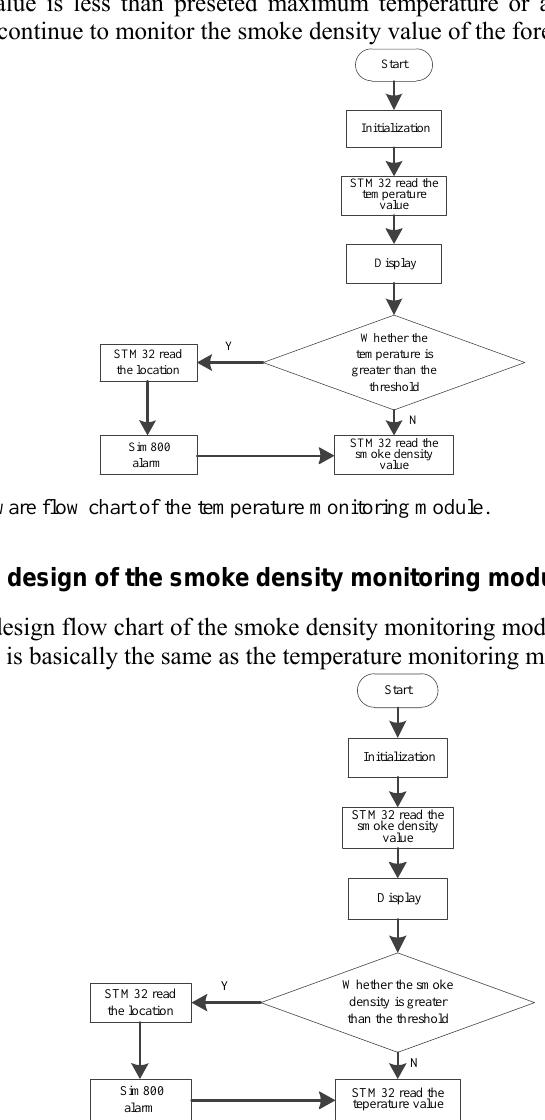
Fig. 10 . The software flow chart of the smoke density monitoring